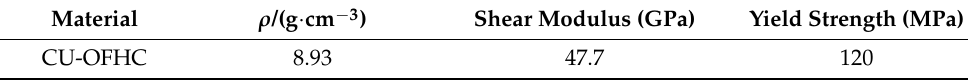
Table 3. Physical properties of water.